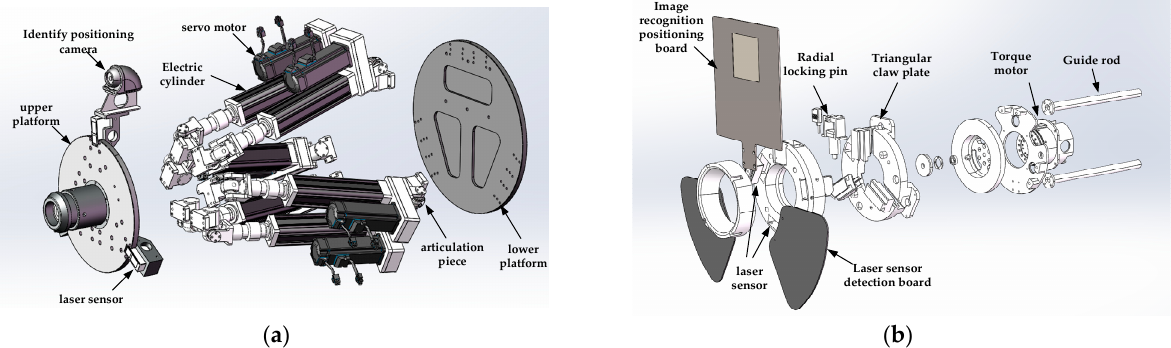
Figure 2. An exploded view of the docking mechanism, where ( a ) is an exploded view of the active mechanism and ( b ) is an exploded view of the locking mechanism.